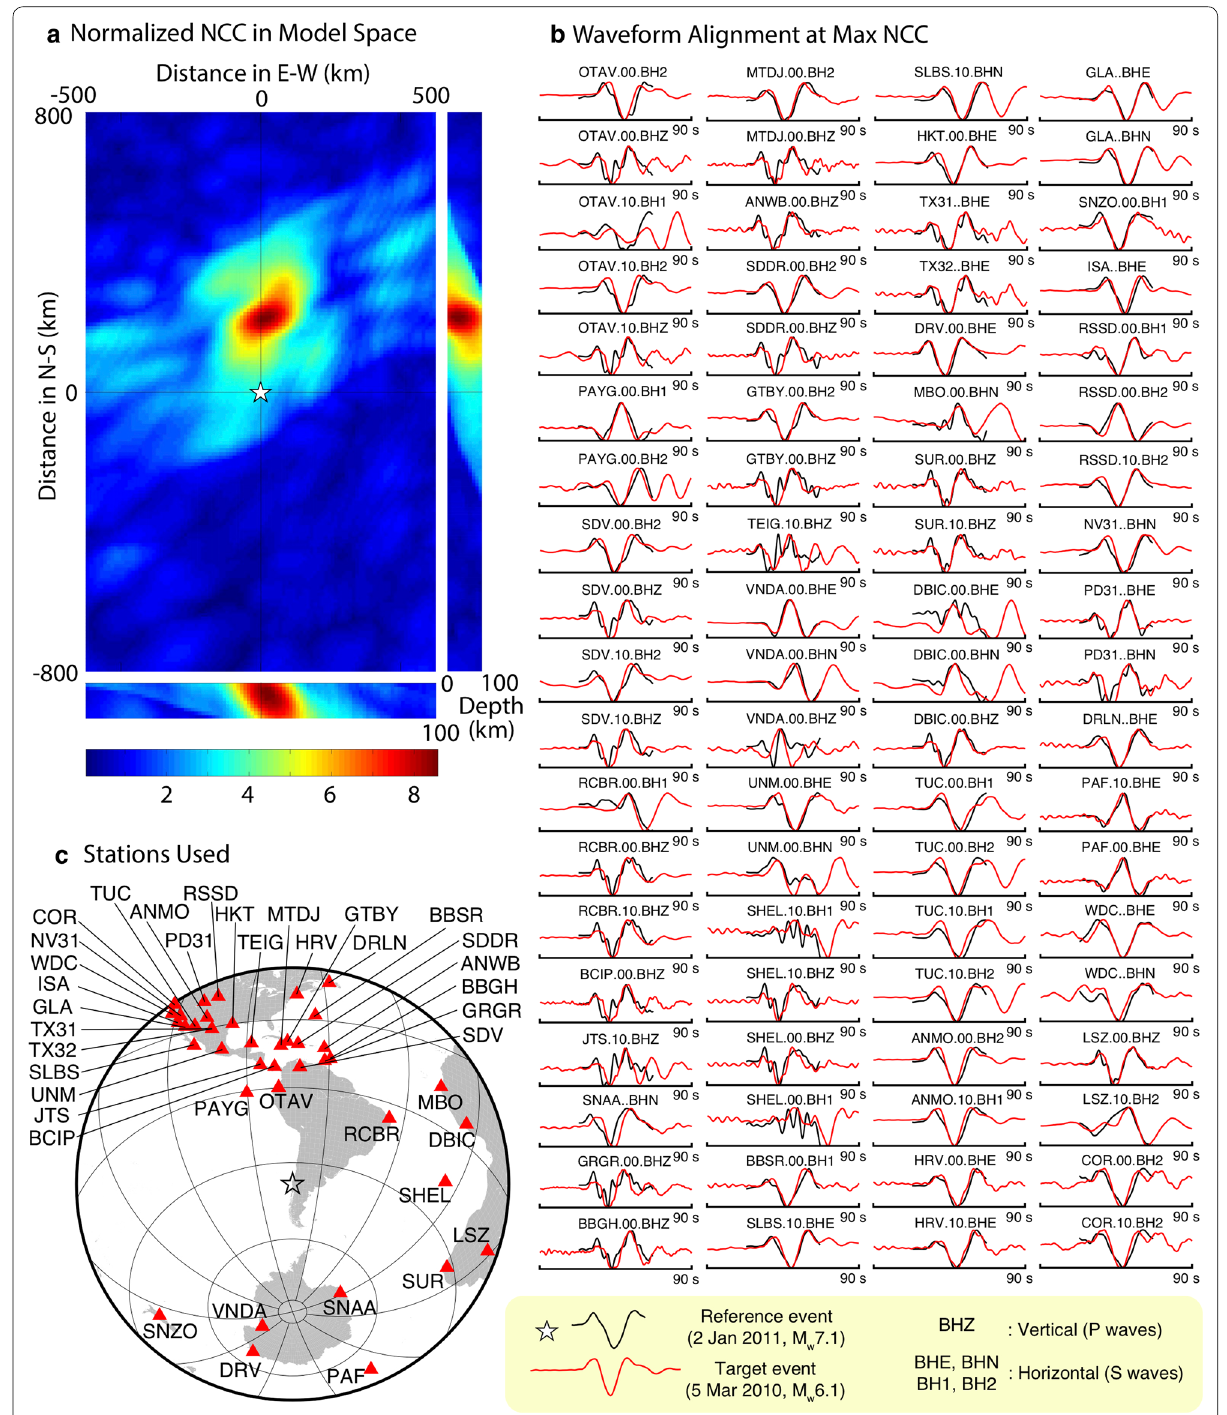
Fig. 2 Example grid‑search analysis to determine the relative location in the Maule region, Chile. a Example grid search to determine the relative event location using the NCC values normalized by their standard deviation. b Alignment of the convolved waveforms for the two events when the maximum NCC value is reached. The event waveforms in b are normalized by their maximum amplitudes. The stations used in the analysis are shown in c . The black event is the reference event (January 2, 2011; M W 7.1 ), and the red event is the target event (March 5, 2010; M W 6.1 ). The two events are shown as orange points in Fig.